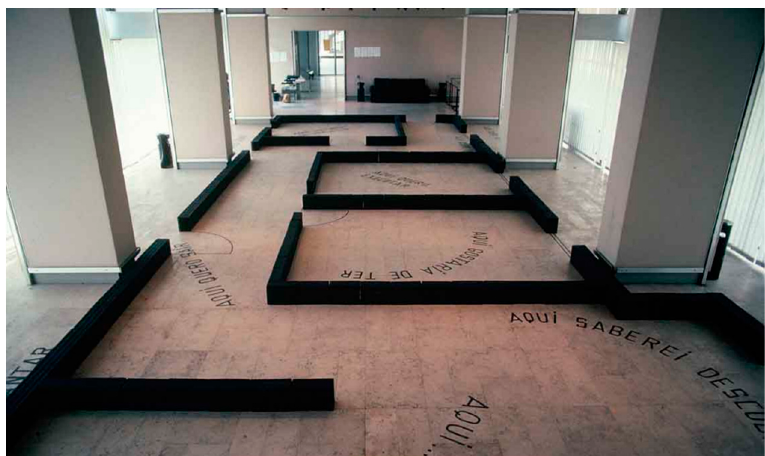
Figure 6. Galeria Quadrum, “Ana Vieira, Ocultação/Desocultação”, 1978. © Quadrum/EGEAC, Galerias Municipais.